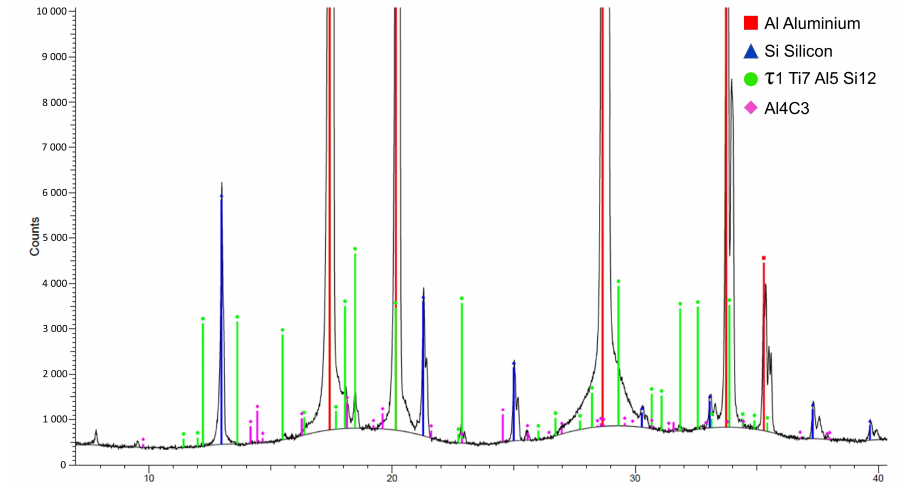
Figure 7. XRD spectrum of the AA4043-TiC wire showing presence of the Al, Si, τ 1 (Ti 7 Al 5 Si 12 ) and Al 4 C 3 phases.